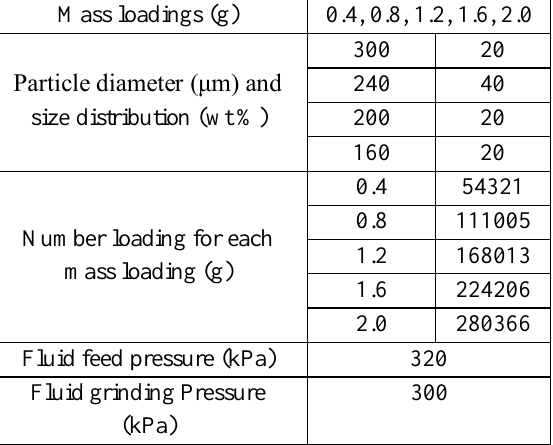
Table 1 : Hold-up study parameters